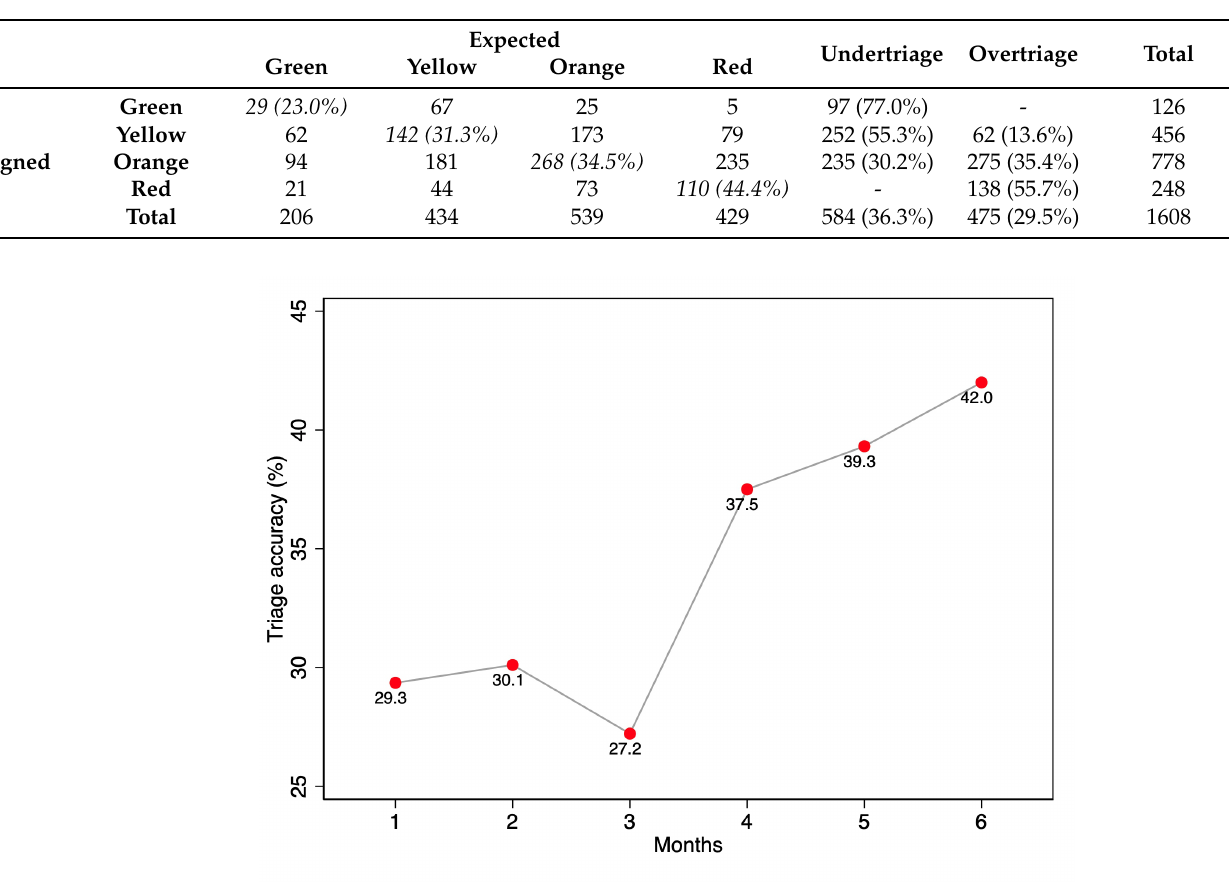
Figure 3. Triage accuracy (proportion of assigned codes matching with expected codes) in the postimplementation